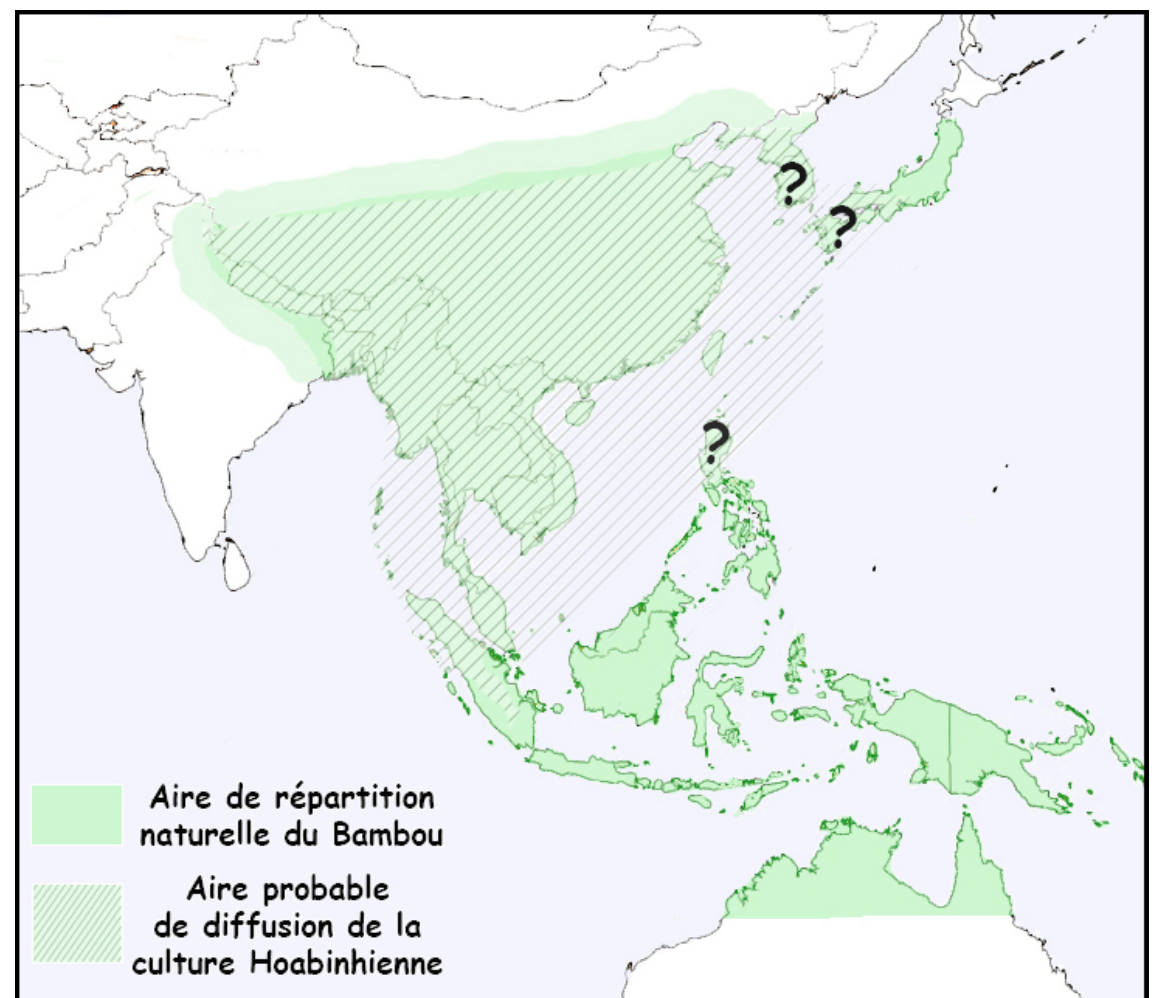
Figure 20. Aire de répartition du bambou et du Hoabinhien en Asie de l’Est et du Sud-Est. Figure 20. Area of the bamboo and Hoabinhian distribution in East and Southeast